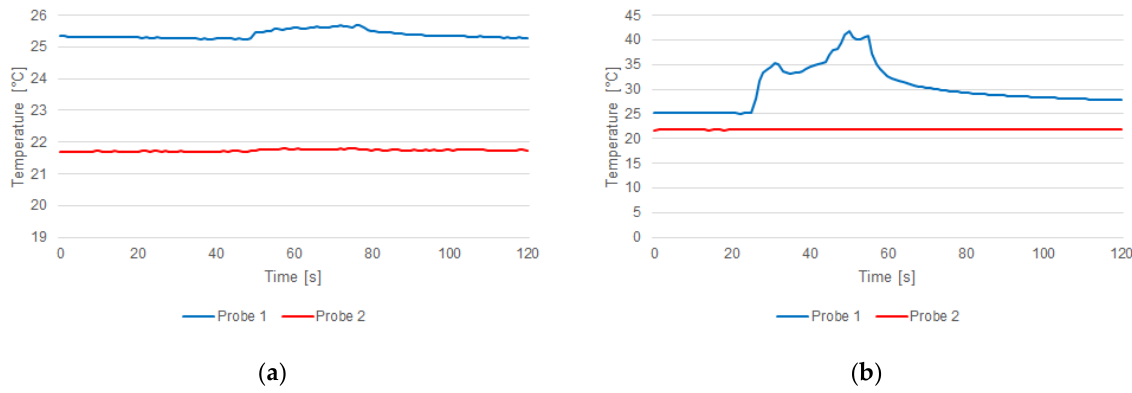
Figure 10. Temperature measured by the optical probe 1 (blue) and probe 2 (red) during sonications #4 ( a ) and #5 ( b ).